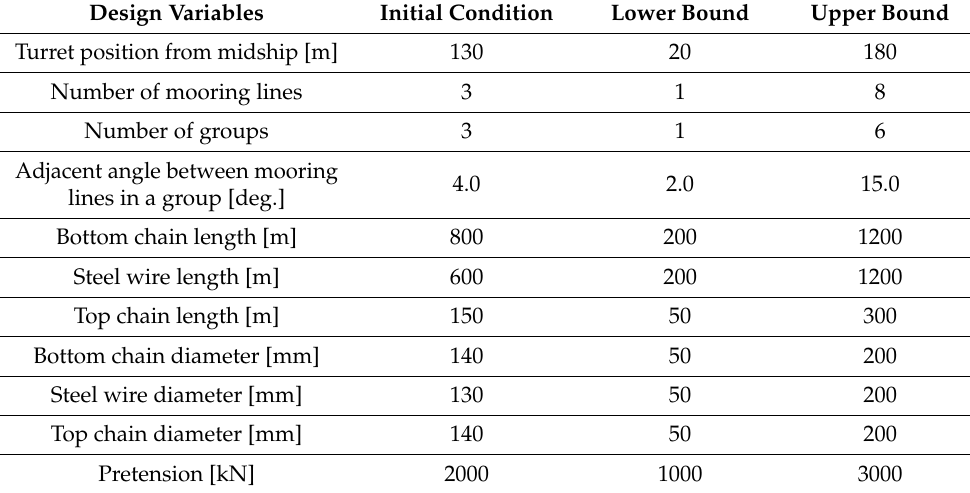
Table 3. The initial values, lower and upper bounds for each design